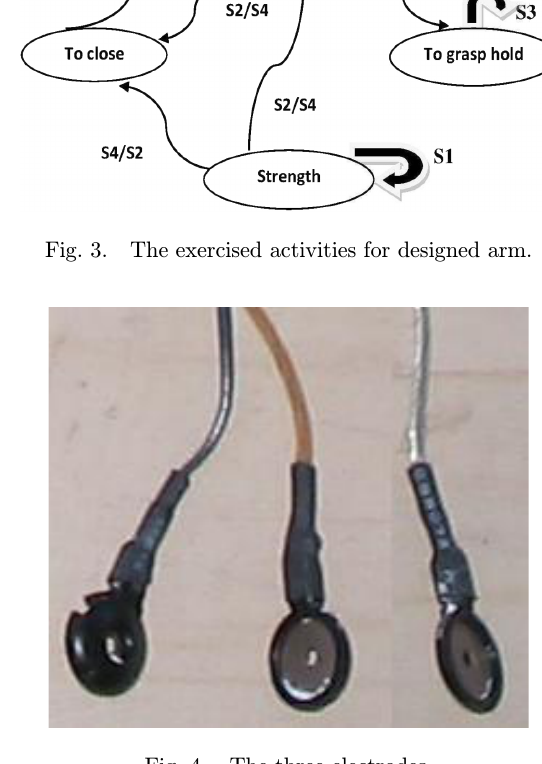
Fig. 4. The three electrodes.